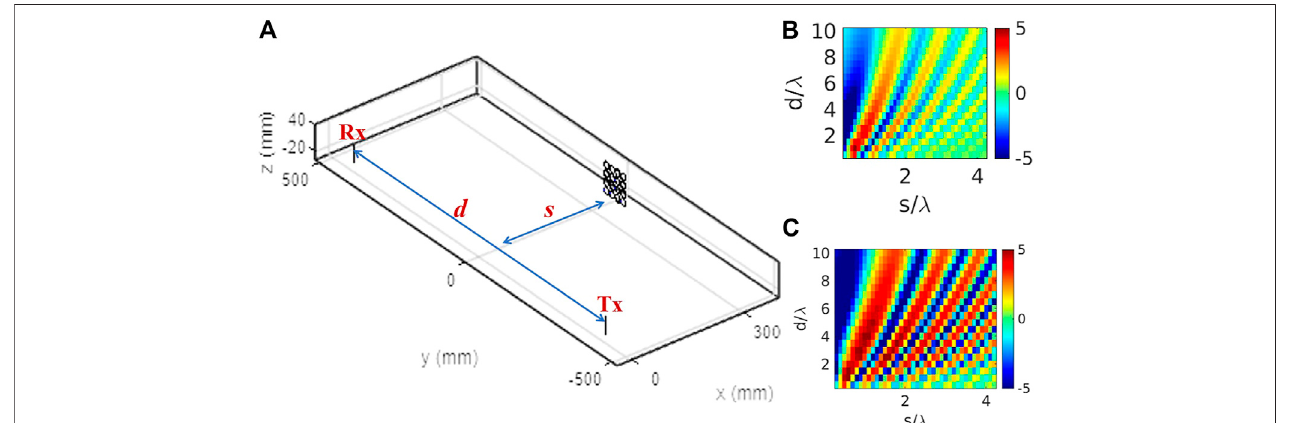
FIGURE 5 | (A) Schematic diagram of alternative IRS-assisted SISO communication link using two 0.47 λ long dipoles, realized using MATLAB Antenna Toolbox. The IRS is kept symmetrically with respect to both Tx and Rx-dipoles, at a distance s from the path connecting the dipoles. The corresponding variations of Δ P (in dB) with respect to s / λ and d / λ , considering: (B) r (cid:1) 0.1 λ , (C) r (cid:1) 0.2 λ . Here p (cid:1) 2 r +2 mm.